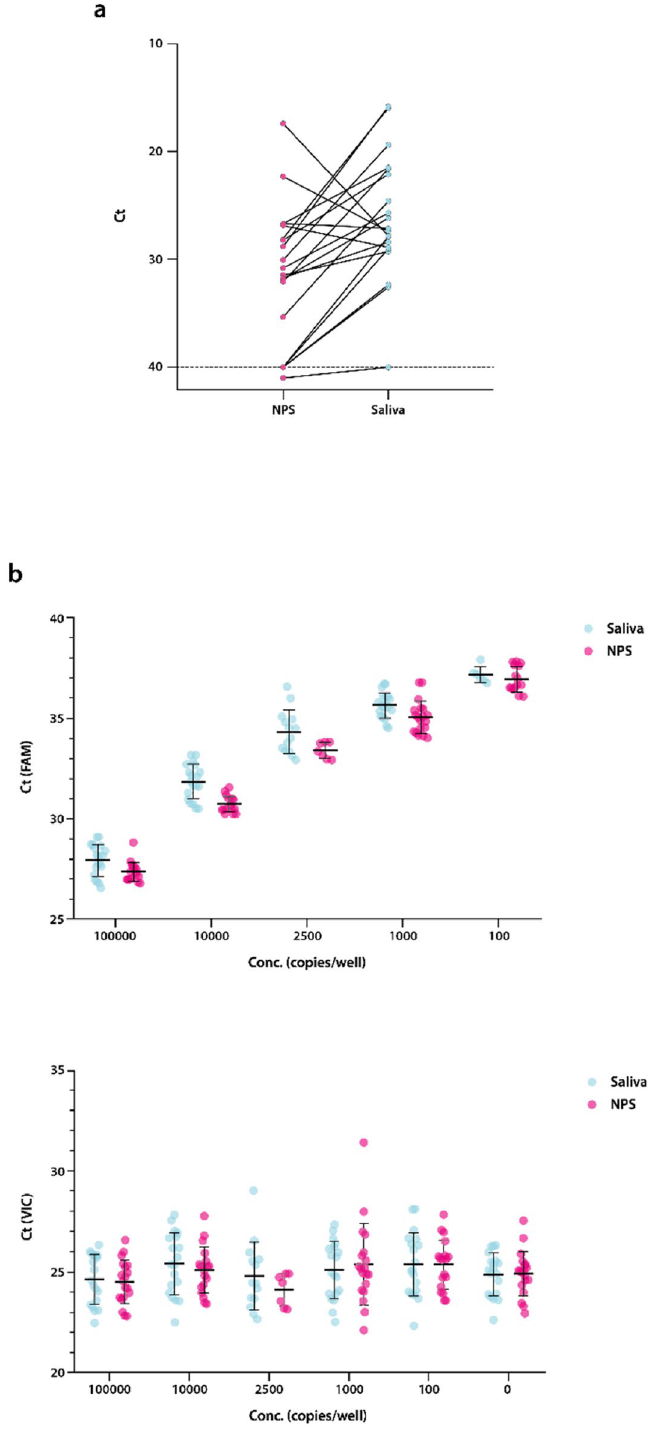
Figure 2. Clinical and analytical validation of the SARS-CoV-2 PCR tests enabling the transition from nasopharyngeal swabs (NPS) to saliva. ( a ) Analysis of 20 paired clinical saliva samples and NPS tested using the Taqpath RT-PCR COVID-19 combo kit, Thermo Fisher Scientific Inc. Cycle threshold (Ct) values for all samples/detectors were generated using the Design and Analysis Software version 2.4.3 (Thermo Fisher Scientific Inc), N gene data shown, with equivalent results seen using the genesig COVID- 19 Real-Time PCR assay, PrimerDesign (PD) (data not shown). ( b ) Comparison of the analytical sensitivity of testing saliva samples and NPS, conducted on contrived samples using the PD assay. The sensitivity for detecting SARS-CoV-2 was similar for both sample types (FAM), and sample type had no effect on extraction or amplification